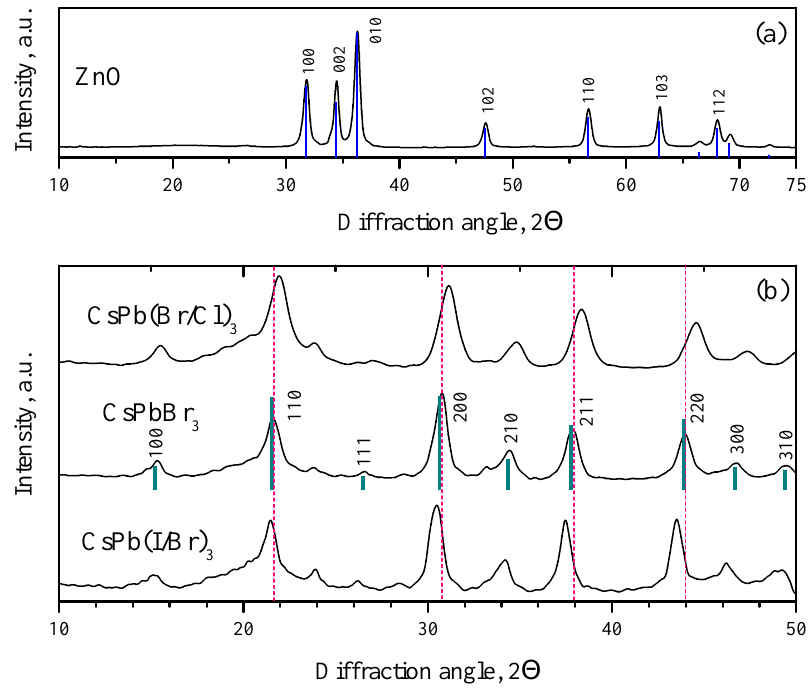
Figure 3. XRD patterns of nanocrystalline ZnO ( a ) and perovskite nanocrystals ( b ). The bar diffraction pattern corresponds to the reflections of the standard diffraction pattern of the cubic phase CsPbBr 3 (00-054-0752,